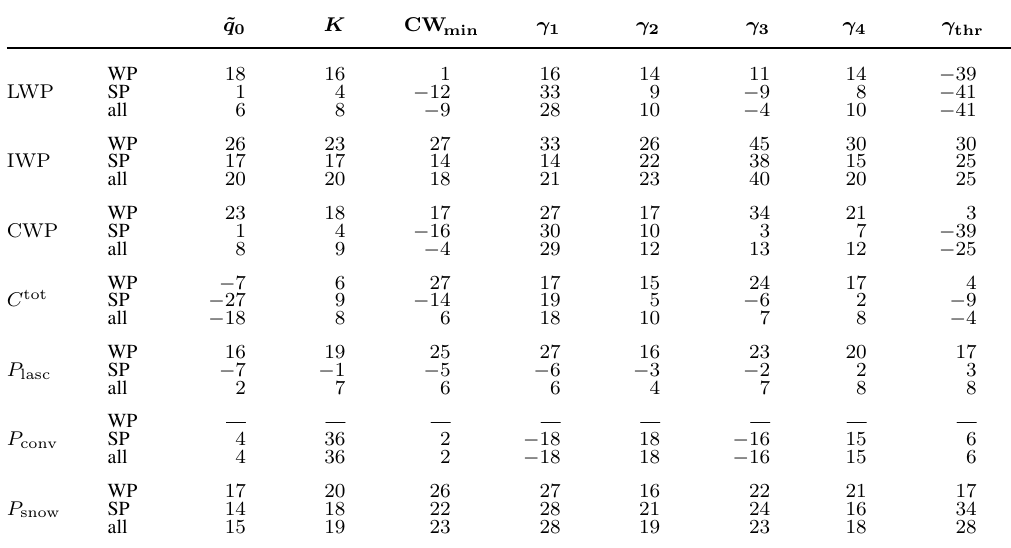
Same as Table 4 but for higher parameter values ( ˜ q